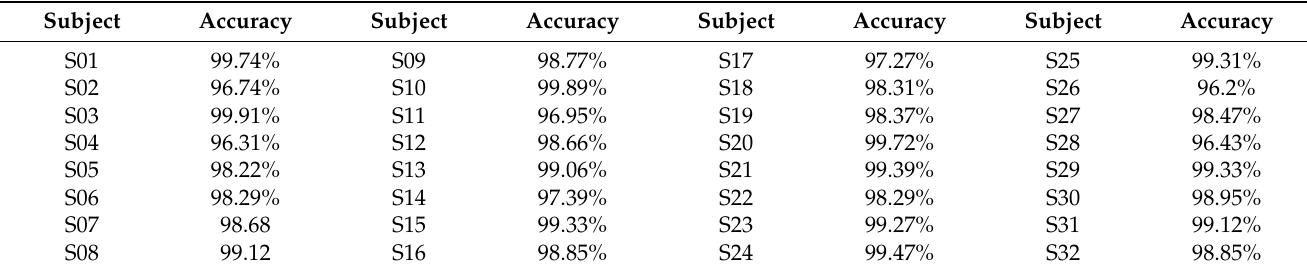
Table 4. Recognition Accuracy for each subject on “Arousal”.